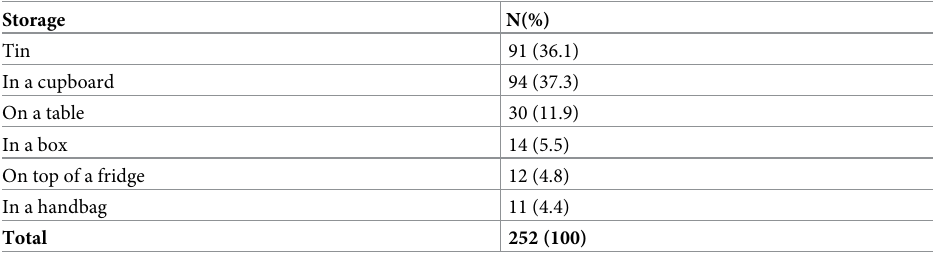
Table 1. Storage places for medications at